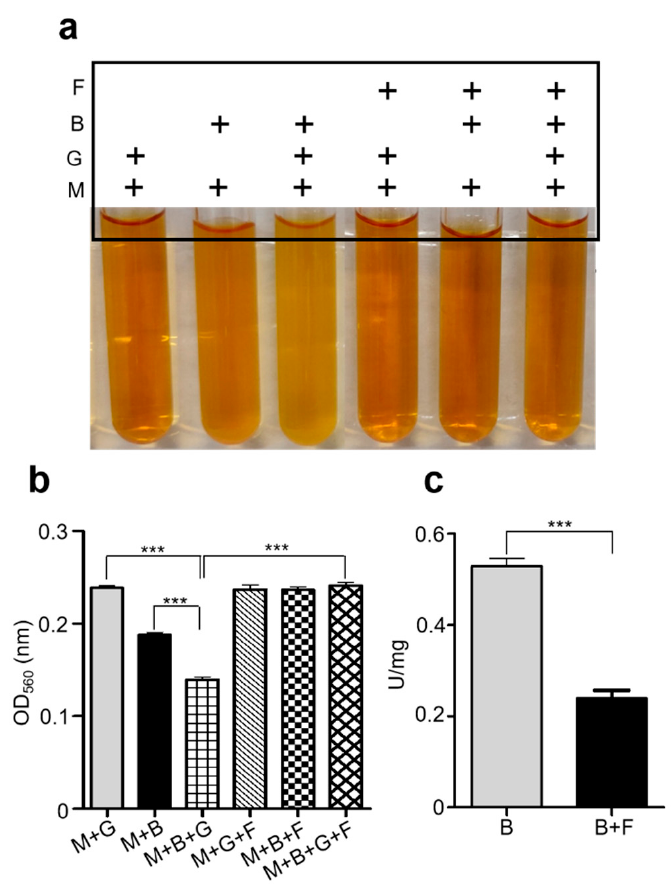
Figure 1. S. epidermidis mediates glycerol fermentation by ALS (acetolactate synthase) enzyme activity. ( a ) S. epidermidis bacteria (B) (10 7 CFU / mL) were incubated in rich media (M) containing phenol red with or without 2% glycerol (G) and in the presence and absence of fermentation inhibitor furfural (F) for 12 h. Media with glycerol (M + G), bacteria (M + B), furfural (M + F), glycerol plus furfural (M + G + F), or bacteria plus furfural (M + B + F) were taken as controls. Bacterial fermentation was indicated by the color change of phenol red to yellow (arrow). ( b ) A graph showing the OD 560 value in all the above groups. ( c ) ALS activity by furfural. The reaction mixture containing lysates of S. epidermidis bacteria (B) (10 7 CFU / mL) was incubated with and without furfural (F). The activity (U / mg) of ALS in S. epidermidis bacteria was quantified. Data shown represent the mean ± SE of experiment performed in triplicate. *** p < 0.001 (two-tailed t